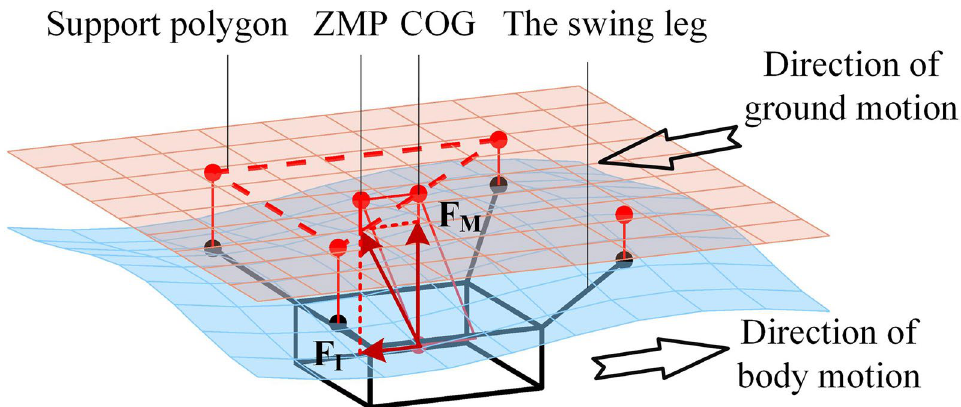
Figure 2 Derivation of ZMP